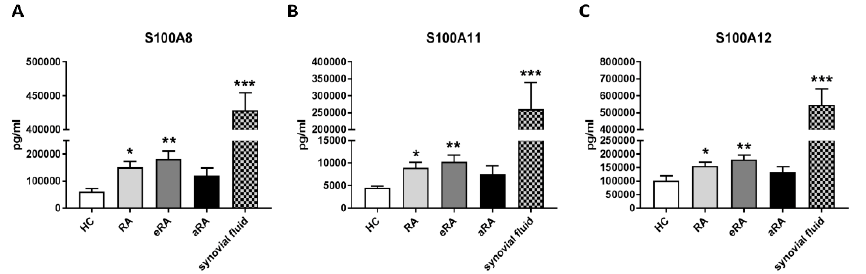
Figure 3. The levels of the S100A8, S100A11, and S100A12 proteins in the bodily fluids of RA patients: S100A8 ( A ), S100A11 ( B ), and S100A12 ( C ) protein concentrations in the sera of RA patients ( n = 37 – 39), with early RA (eRA) ( n = 18–20) and advanced RA (aRA) ( n = 19), compared with HCs ( n = 14–15). S100A8 ( A ), S100A11 ( B ), and S100A12 ( C ) protein concentrations were determined in the synovial fluid (SF) of RA patients ( n = 4) compared to the serum concentrations of HCs ( n = 14 – 15). p values were expressed as follows: 0.05 > p > 0.01 as *, 0.01 > p > 0.001 as **, 0.001 > p > 0.0001 as ***